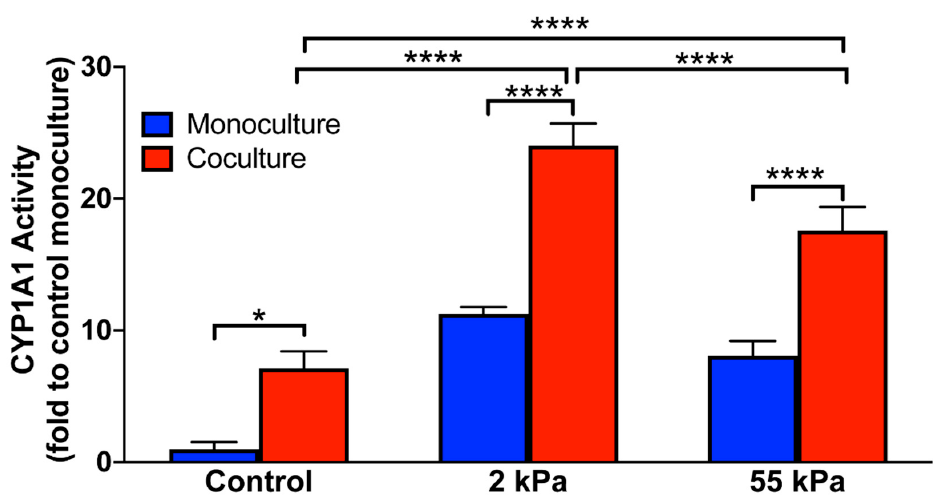
Figure 4. Quantification of cytochrome P450 activity of primary hepatocytes when cultured on soft, stiff and TCPS substrates on day 10 of culture. Error bars indicate standard deviation of the mean for n = 5 samples. * p < 0.05, **** p < 0.0001.